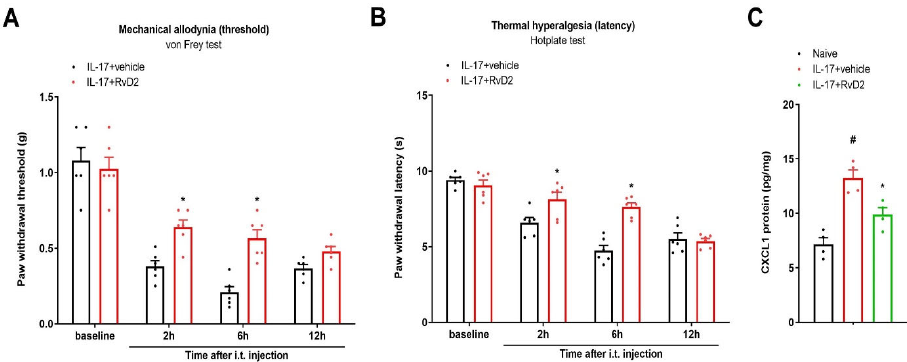
Figure 6. Generation of acute pain by IL ‐ 17 exposure was reduced after co ‐ administration of RvD2. RvD2 (i.t., 500 ng) was administered 1 h prior to recombinant IL ‐ 17 application (i.t., 400 ng). Mechanical allodynia was evaluated by measuring paw withdrawal threshold ( A ) using von Frey experiments, and thermal hyperalgesia was evaluated by measuring paw withdrawal latency ( B ) using hotplate experiments. Exogenous IL ‐ 17 ‐ induced acute pain behaviors were ameliorated by co ‐ application of RvD2. ( C ) ELISA assay showed that RvD2 administration inhibited the elevated expressions of spinal CXCL1 proteins in IL ‐ 17 ‐ treated animals. Behavioral results are presented as the mean ± SEM ( n = 6) and compared using two ‐ way ANOVA followed by Bonferroni multiple comparisons. Results from biochemical experiments are presented as the mean ± SEM ( n = 4) and compared using one ‐ way ANOVA followed by Bonferroni multiple comparisons. # p < 0.05 vs. group naïve. * p < 0.05 vs. group IL ‐ 17 + vehicle. i.t. = intrathecal injection.